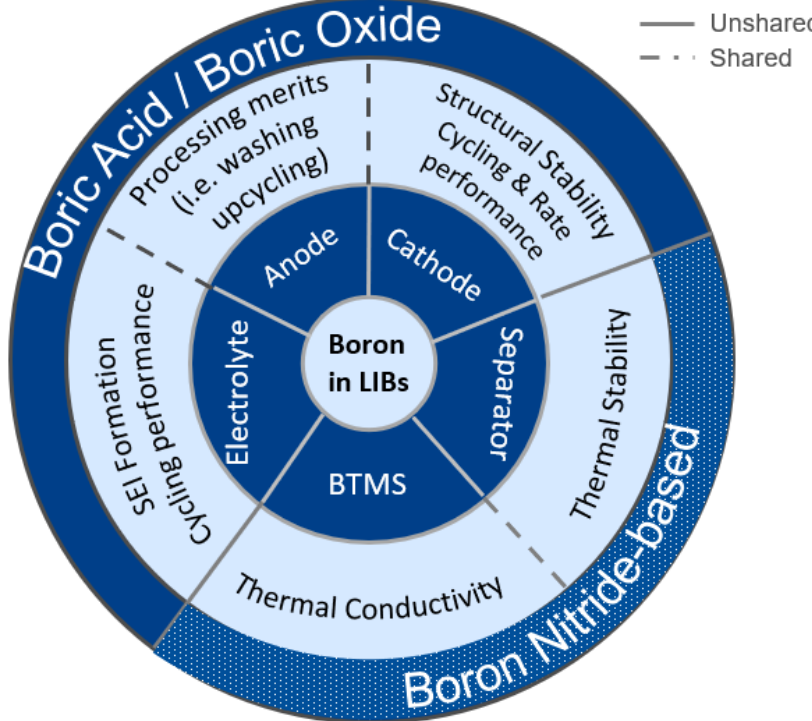
Figure 8. Generalized benefit and studied boron compounds in five LIBs components.